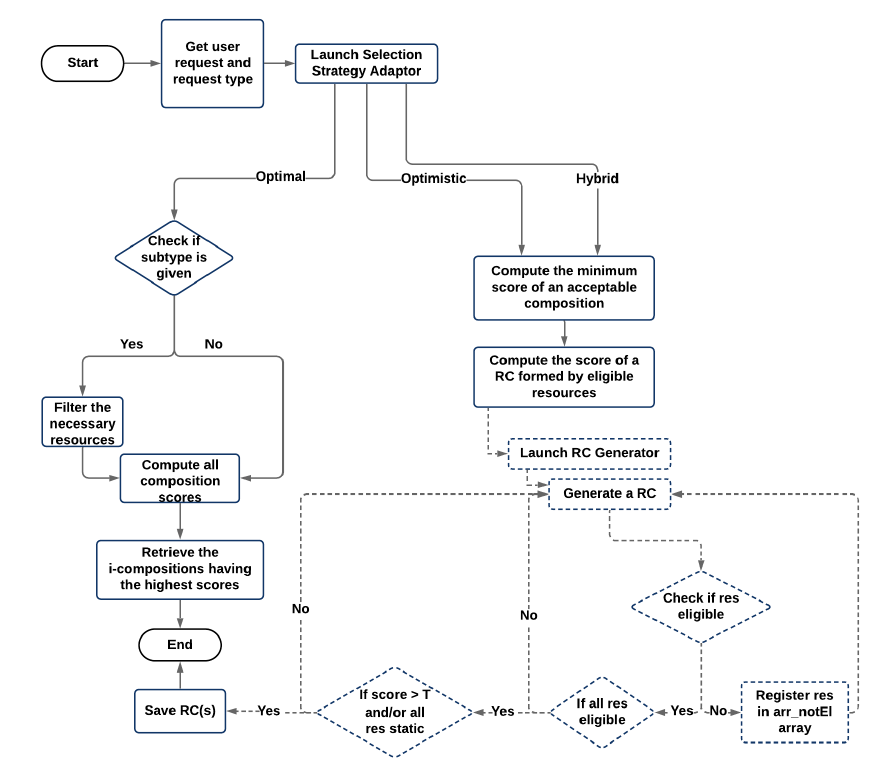
Figure 6. Flowchart of the selection process and its related